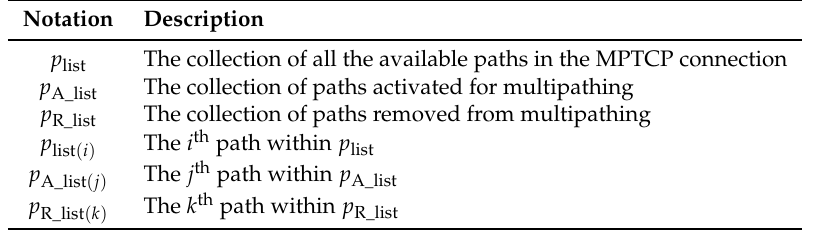
Table 2. Notations used in the MPTCP-LM 3 based multipath management algorithm.